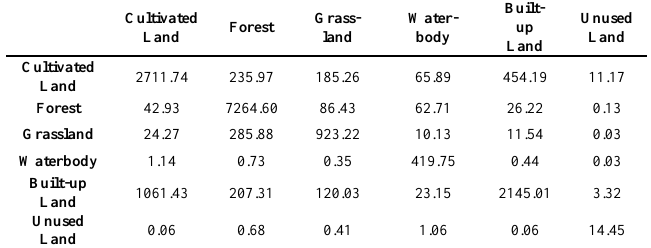
Table 5. Conversion of Land Types from 2020 to 2035 ND scenario (km 2 ).